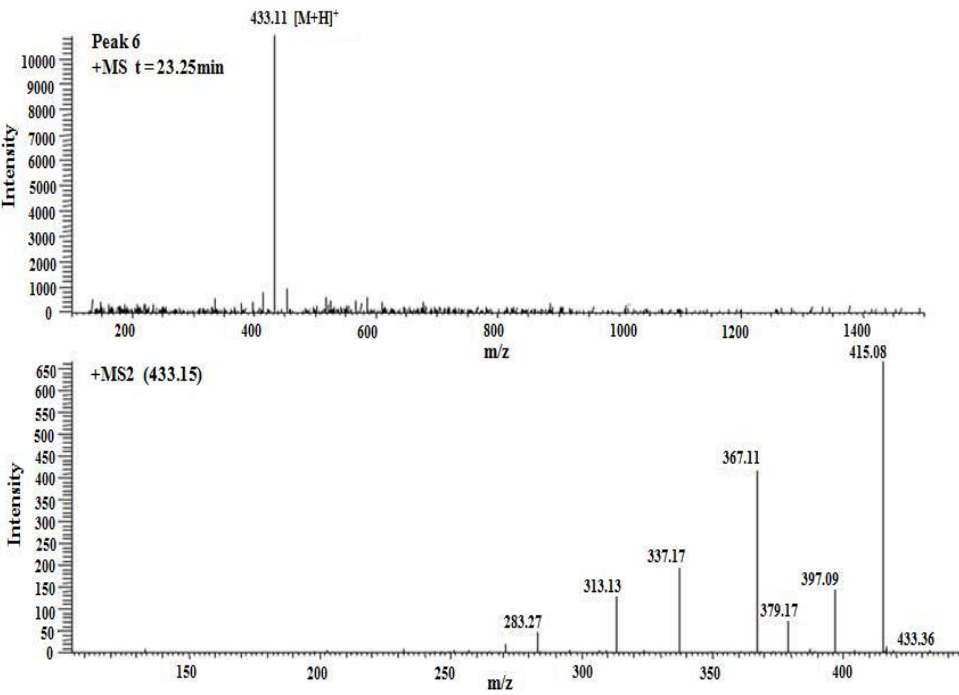
Figure 5. Positive ion ESI mass spectra and MS n spectra of peak 6.